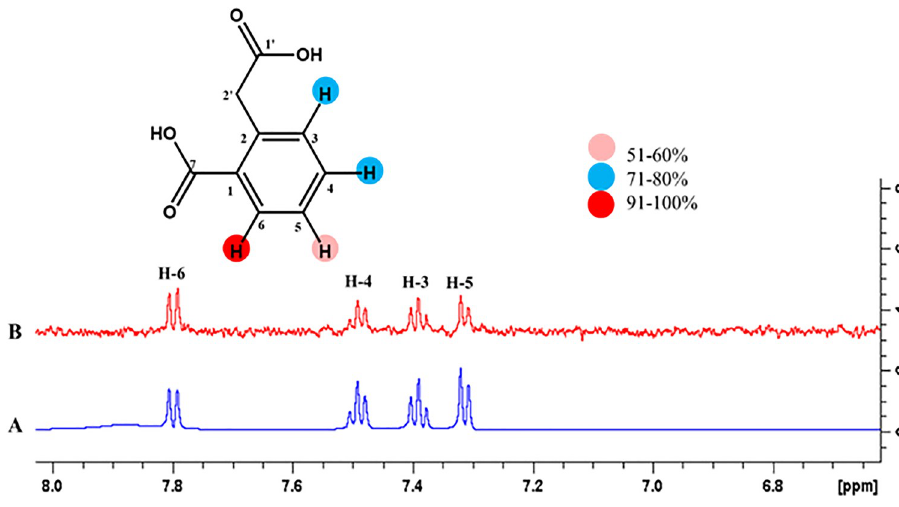
Fig 21. (A) Reference 1 H-NMR spectrum of ligand 26. (B) Difference spectrum of ligand 26 with